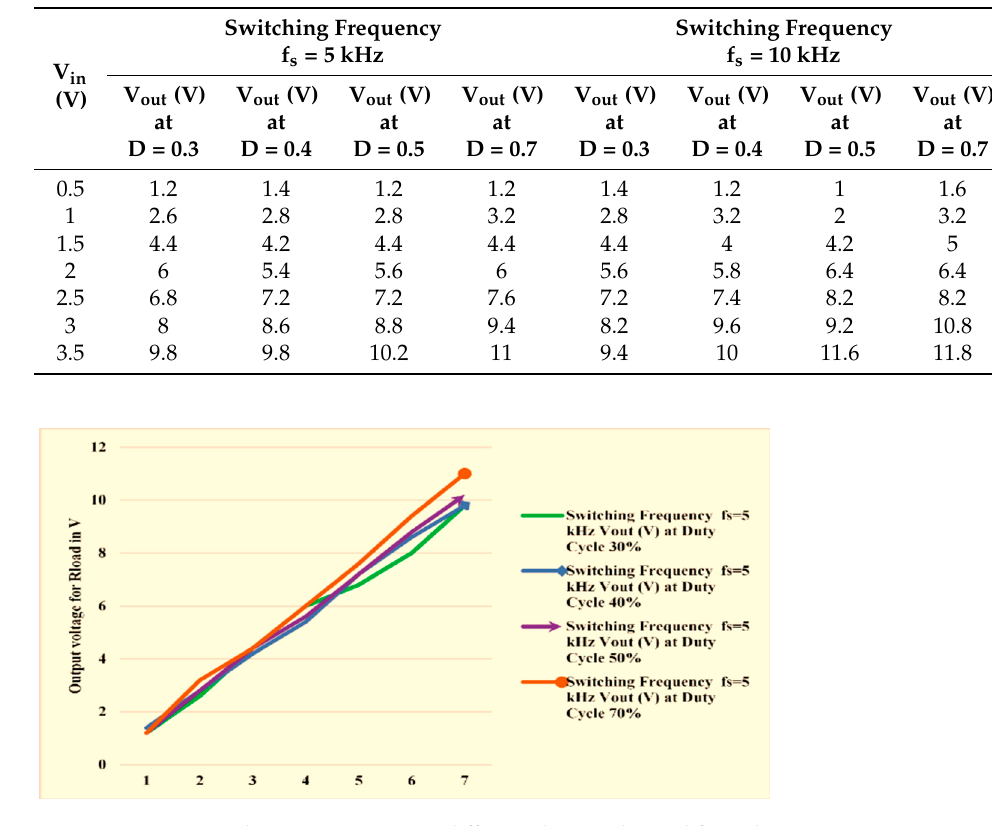
Table 12. Output voltage, current and power comparison at f s = 5 kHz and f s = 10 kHz.